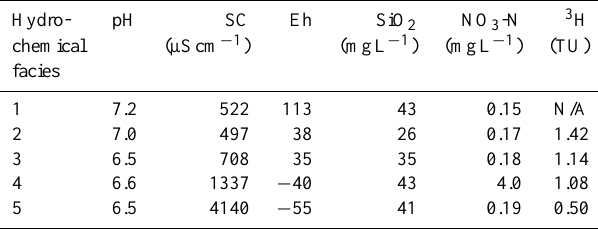
Table 6. Main features of the five hydrochemical facies (median